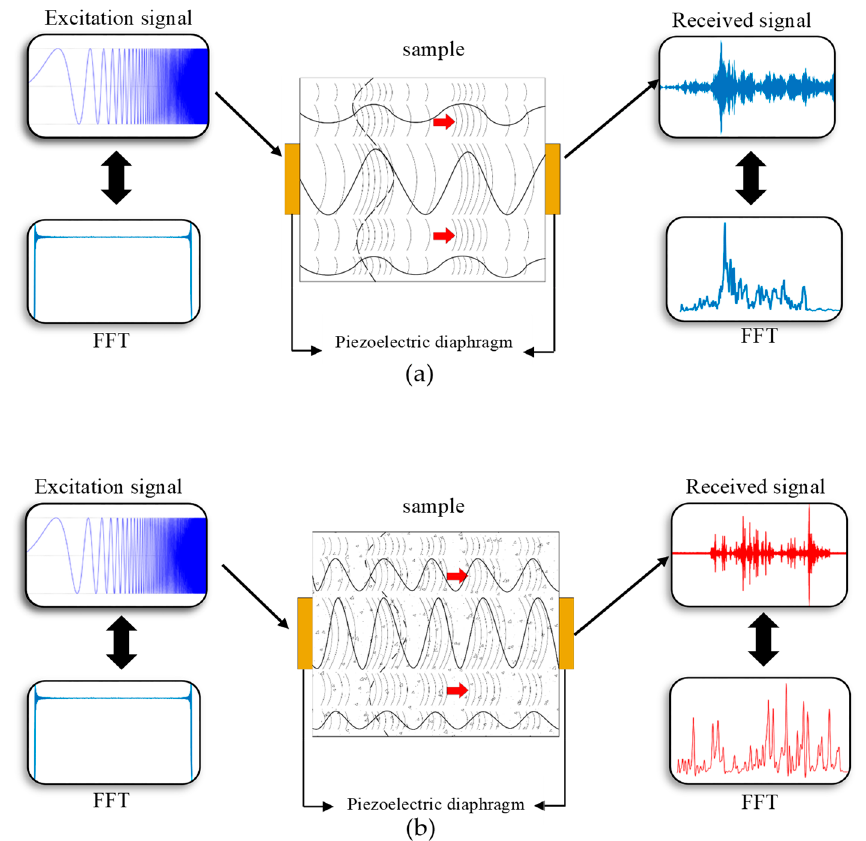
Figure 2. Chirp-Through-Transmission Technique: ( a ) health structure; ( b ) damaged structure.